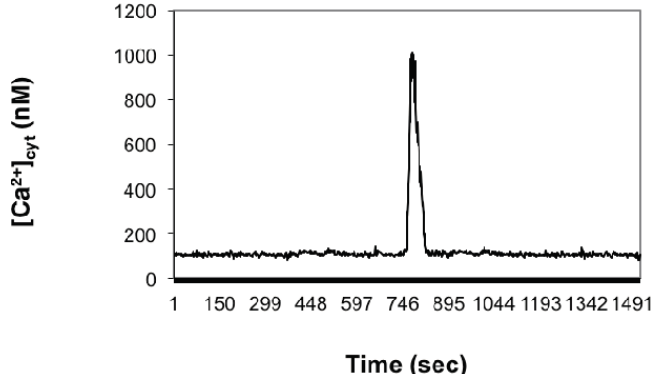
Figure 4. [Ca 2+ ] cyt dynamics in a receptive egg cell isolated six DAE and fertilized in vitro in fusion medium containing 10 µM (final concentration) of GdCl 3 . Time was measured from the successful incorporation of the sperm into the egg’s cytoplasm. The onset of the rise in [Ca 2+ ] cyt elicited by the sperm ensued 12 ± 1.4 min, n = 18, following in vitro fusion of the sperm cell with the female gamete.